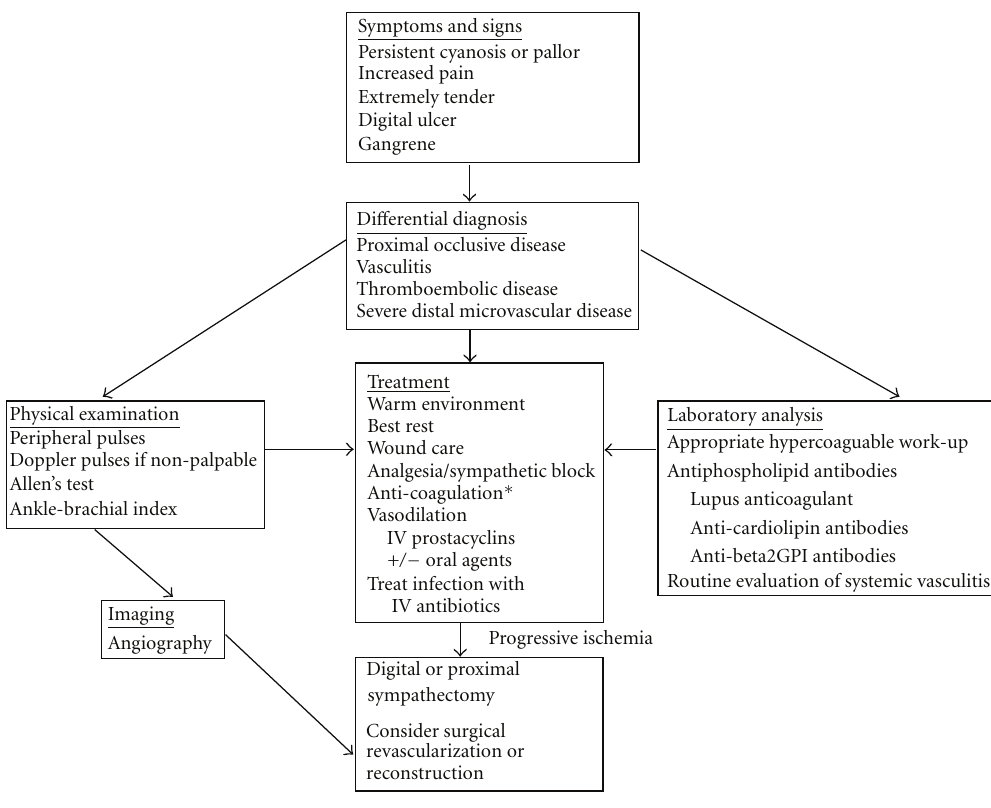
Figure 1: Algorithm for the evaluation and treatment of digital ischemic loss in systemic